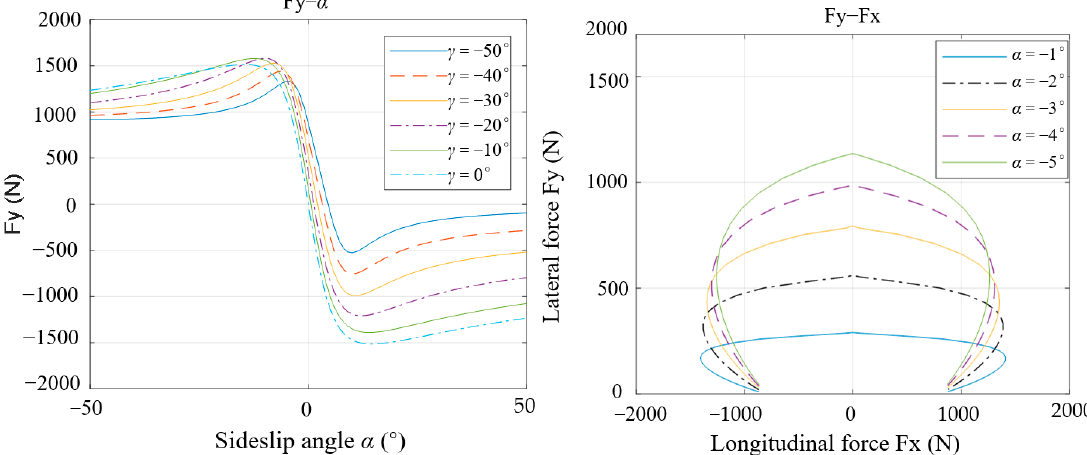
Figure 5. Lateral characteristics of a tire.